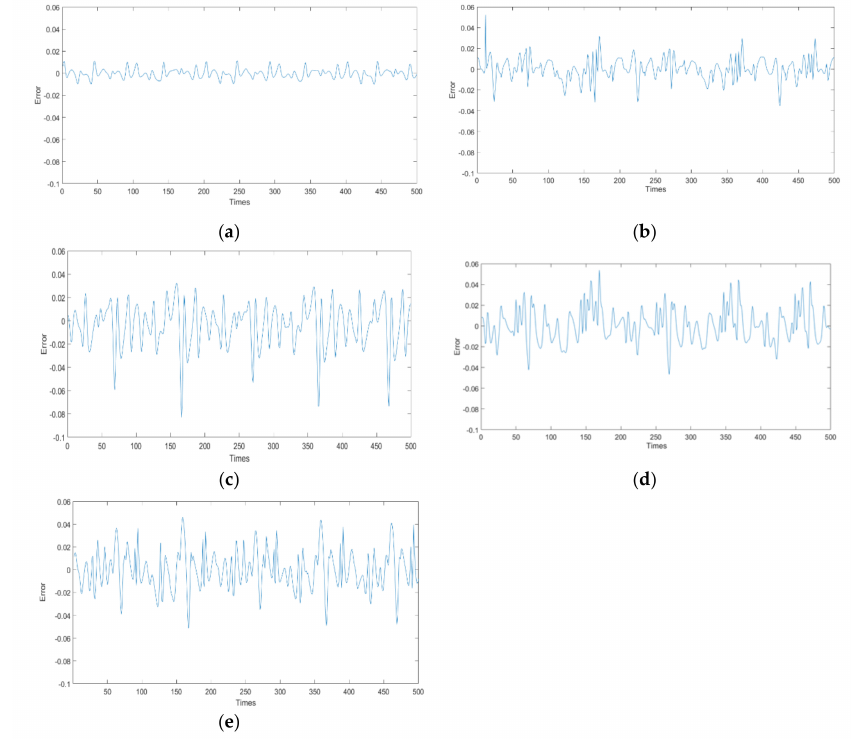
Figure 14. Chaotic time-series prediction error rates of ( a ) DGCPSO, ( b ) DE [24], ( c ) PSO [25], ( d ) QPSO [26], and ( e ) CPSO